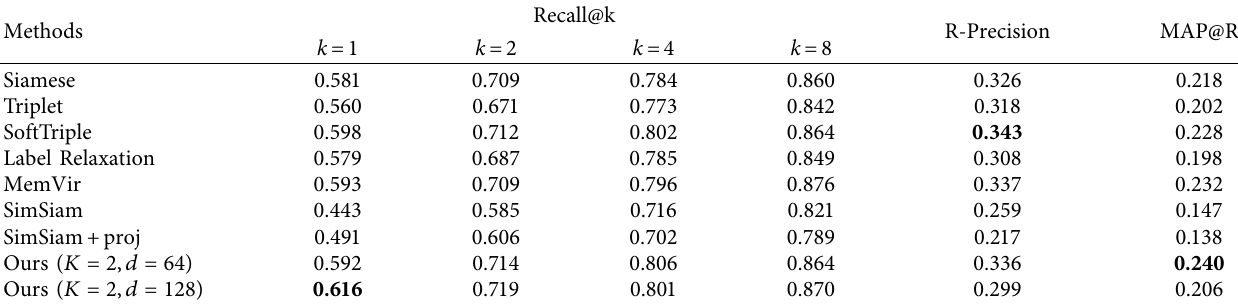
Table 5: Accuracy on Pascal Sentence. K and d denote the number of embeddings and dimensions of metric embedding, respectively.